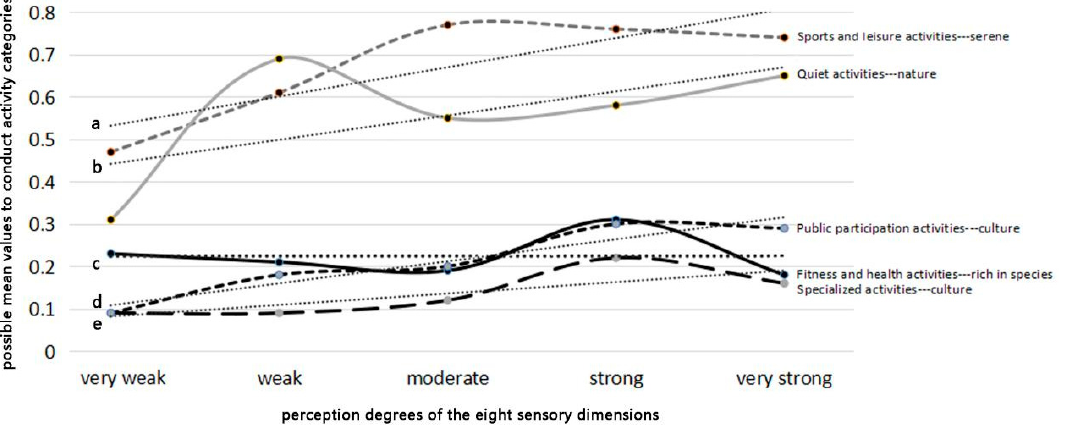
Figure 6. The probable mean values of conducting activity categories varies with the perceived degrees of corresponding sensory dimensions. Note I. “a” represents the trendline of sports and leisure activities. ”b” represents the trendline of quiet activities. ”c” represents the trendline of fitness and health activities. “d” represents the trendline of public participation activities. “e” represents the trendline of specialized activities.